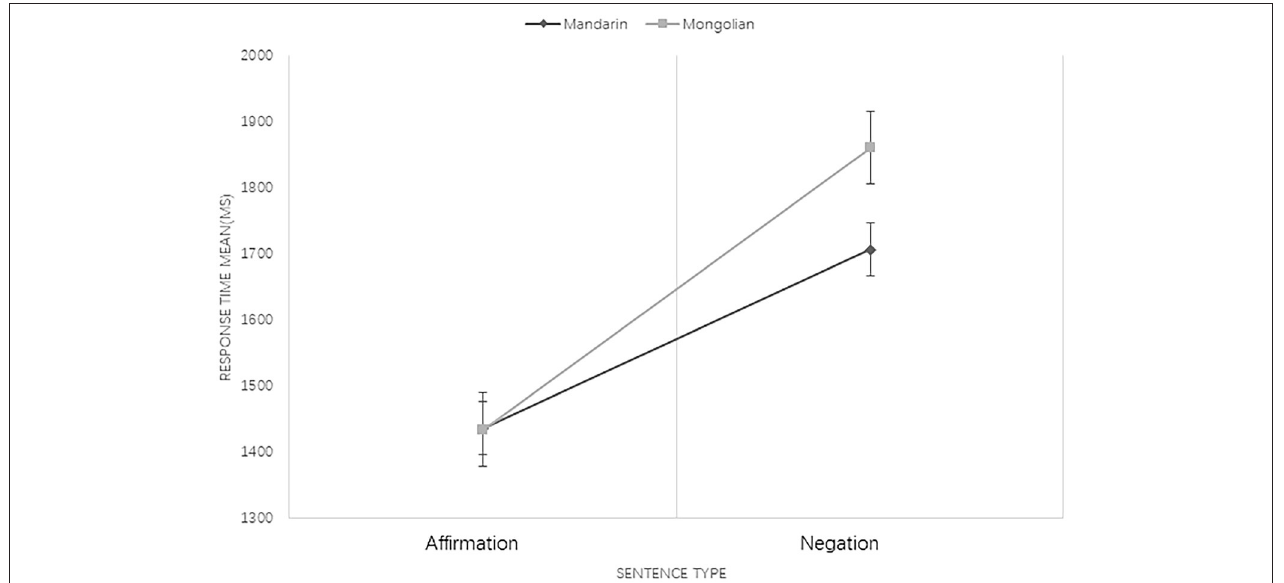
FIGURE 1 | The interaction between language type and sentence type at 250 ISI. Bars represent standard error.